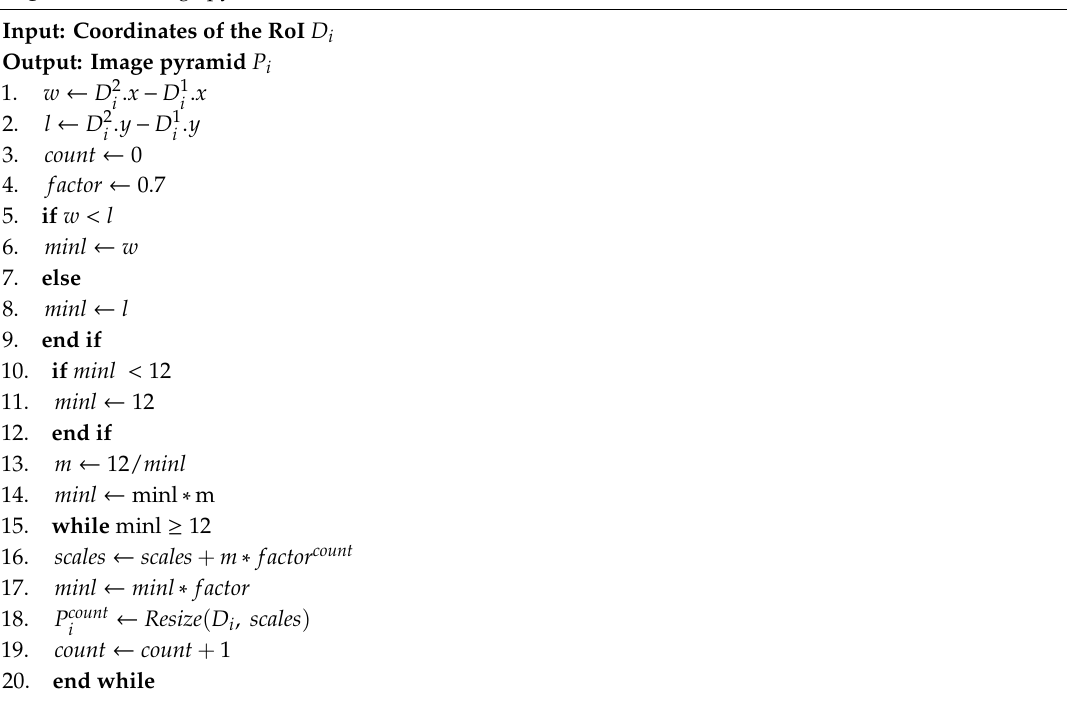
Algorithm 2 . Image